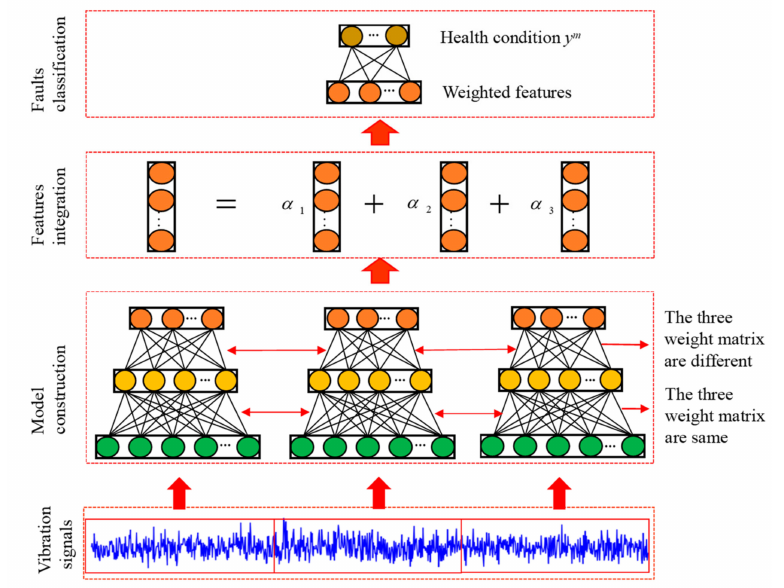
Figure 2. Illustration of the